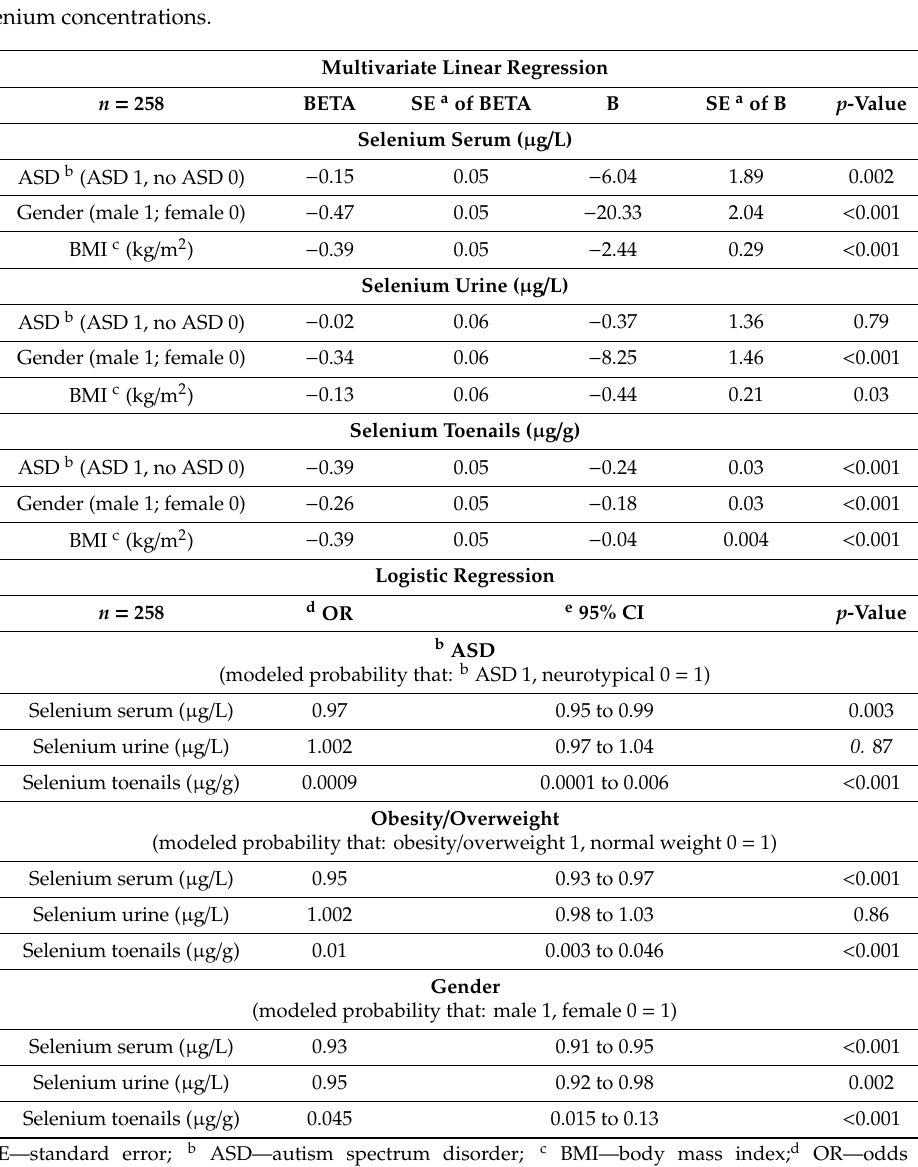
Table 3. Inter-correlations between serum, urine and toenail selenium concentrations pre- and post-pubertally. Statistically significant correlations are highlighted. Spearman’s rank-order correlation test results. Se serum before puberty ( µ g / L) & Se serum after puberty ( µ g / L)